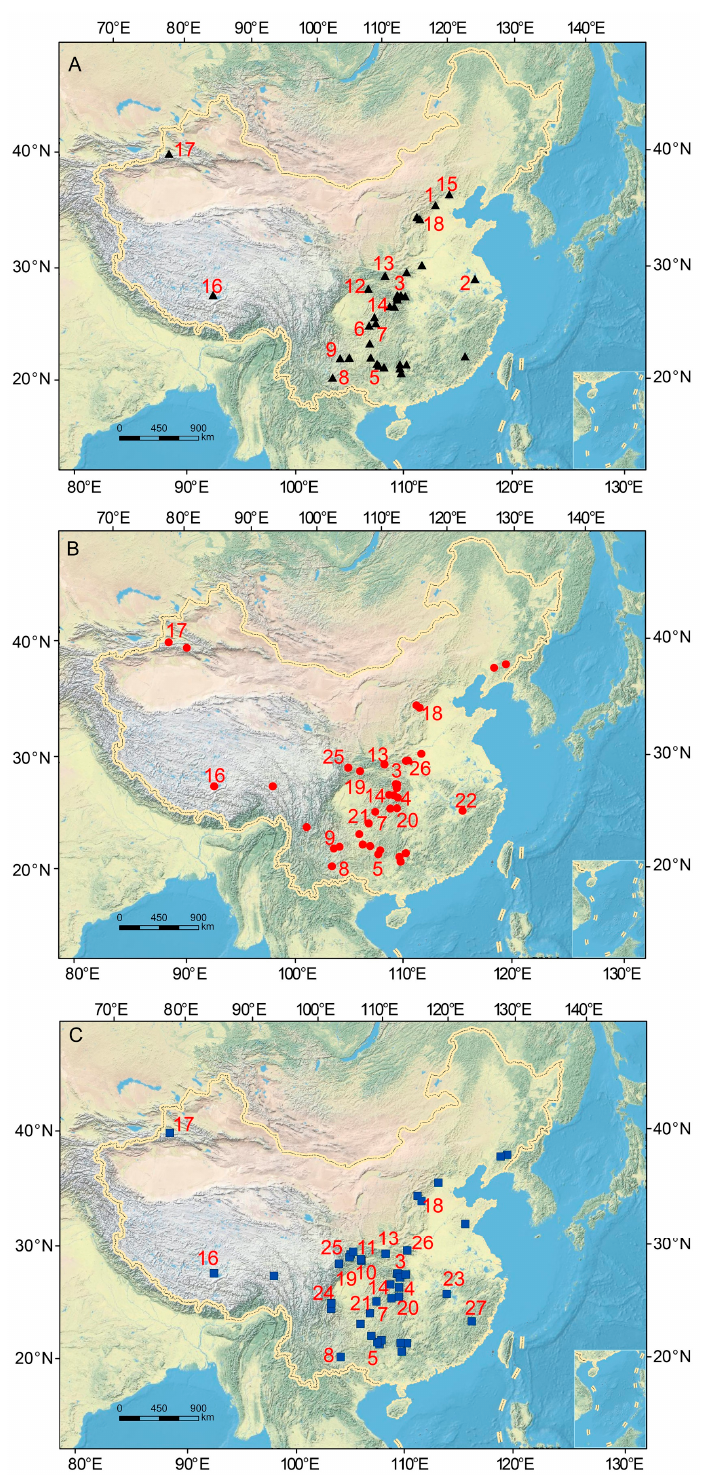
Figure 4. Spatial distribution of speleothem δ 18 O records in China during three periods: ( A ) the Late Pleistocene (640 ka–11.7 ka), ( B ) the Holocene (11.7 ka–Present), and ( C ) the last 2000 years. Cave locations numbered 1–17 are the same as in Figure 1. Numbers 18–27 (18: Lianhua (Shanxi); 19: Xianglong; 20: Lianhua (Hunan); 21: Shigao; 22 Shennong; 23: E’mei; 24: Shenqi; 25: Wanxiang; 26: Dongshiya; 27: Yuhua) are records mentioned in the discussion but not in SISAL_v1. Details on each speleothem are given in Table